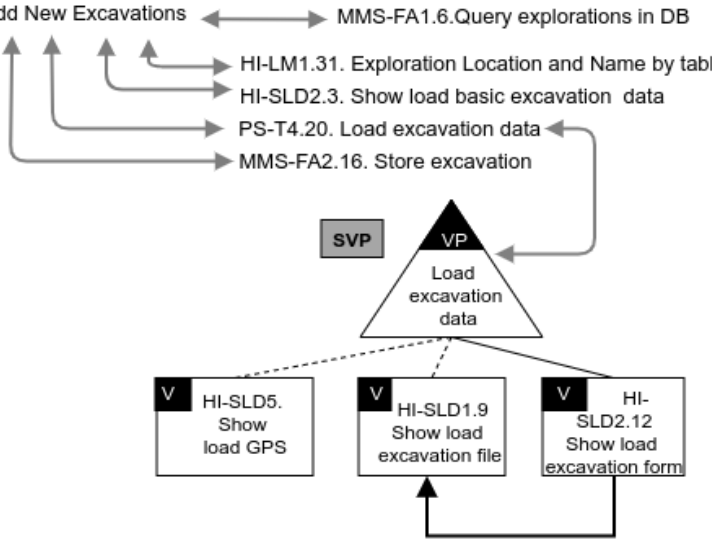
Figure 7. Variability model for Add New Excavations with an